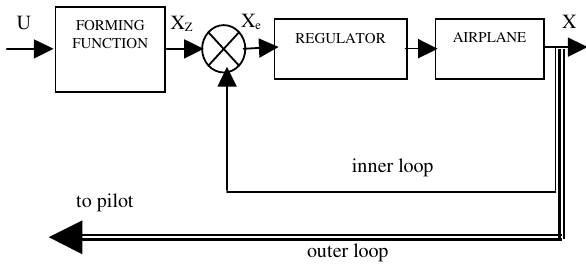
Fig 7. Schematic of control laws using regulators of selected flight parameters. U – position of side stick, X – stabilized value of selected flight parameter, X z – demand value of stabilized flight parameter, X e – stabilization